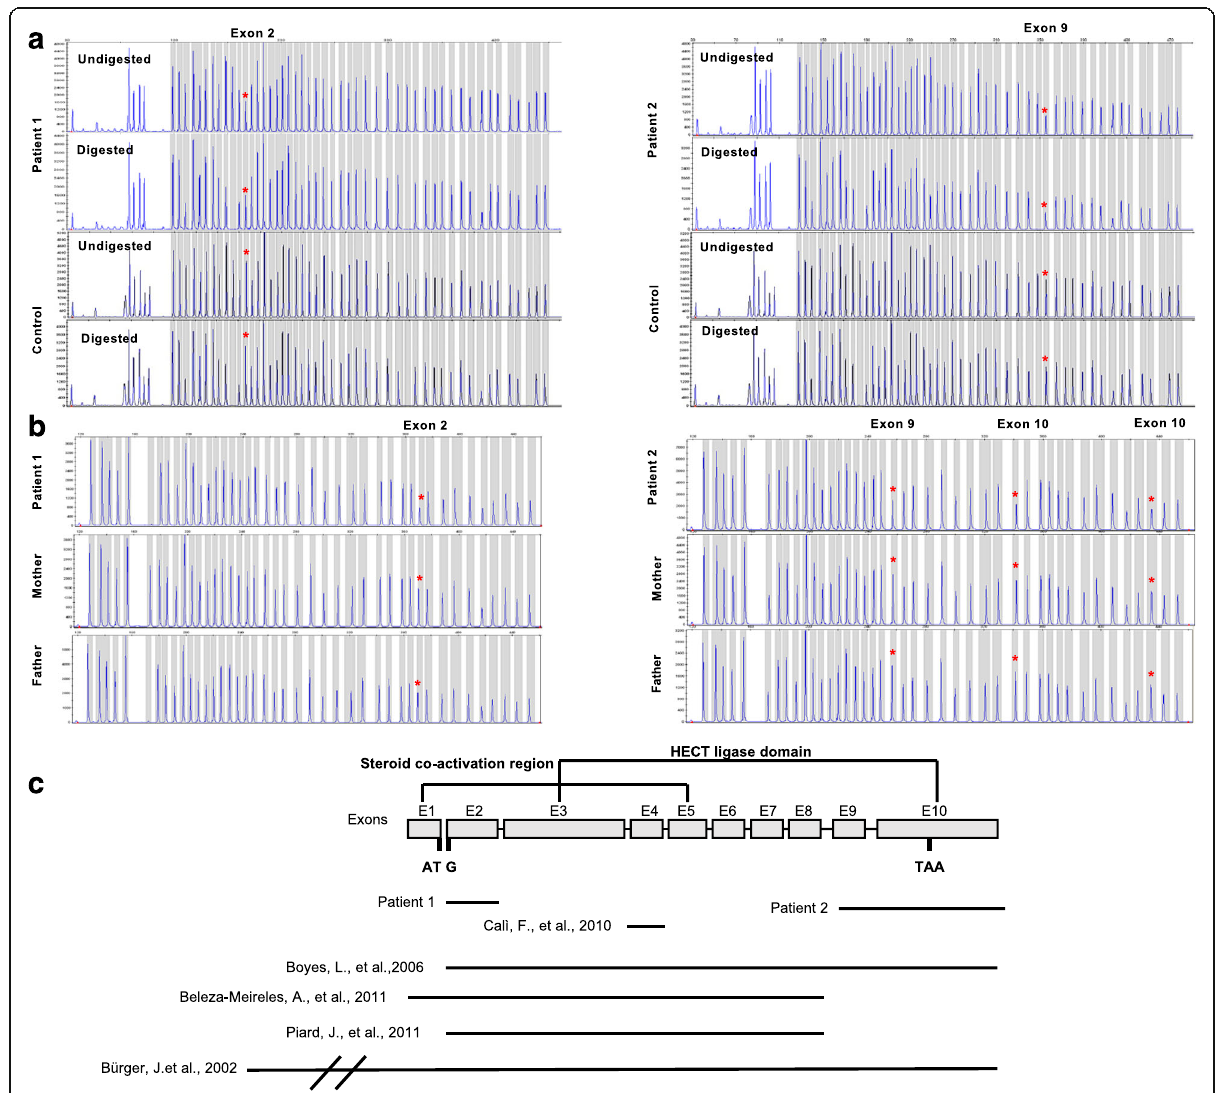
Fig. 1 Two intragenic deletions within the UBE3A gene (NM_130838.1) were identified by MLPA analysis in patients 1 and 2. a MS-MLPA analysis with the ME028-B2 kit shows a normal methylation pattern and a heterozygous deletion of exon 2 in patient 1. A normal methylation pattern and a heterozygous deletion of exon 9 were observed in patient 2. Red asterisks indicate the deleted exons. b MLPA analysis with the kit P336-A2 confirmed the deletion of exon 2 in patient 1 while a deletion involving exon 9 and 10 was observed in patient 2. In both cases the deletions were de novo. Red asterisks indicate the deleted exons. c Summary of UBE3A intragenic deletions identified in this study and the literature. Exons are depicted as grey boxes. Exons 1 to 5 constitute the steriod co-activation region and exons 3 to 10 constitute the HECT ligase domain, according to Ramamoorthy and Nawaz et al., 2008. UBE3A deletions reported here and in the literature are shown as black